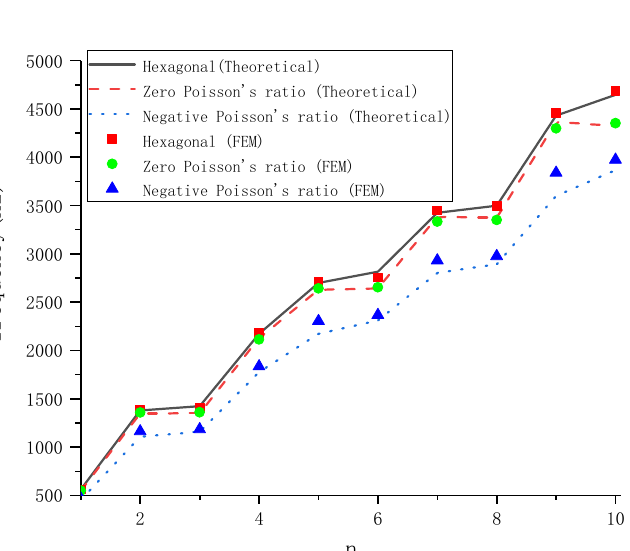
Table 3. Frequencies of ZPR honeycomb plate with core thickness ratio change.